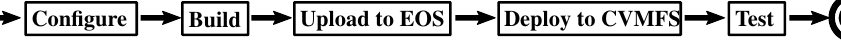
Figure 2. A typical workflow of an LCG stack build pipeline contains these